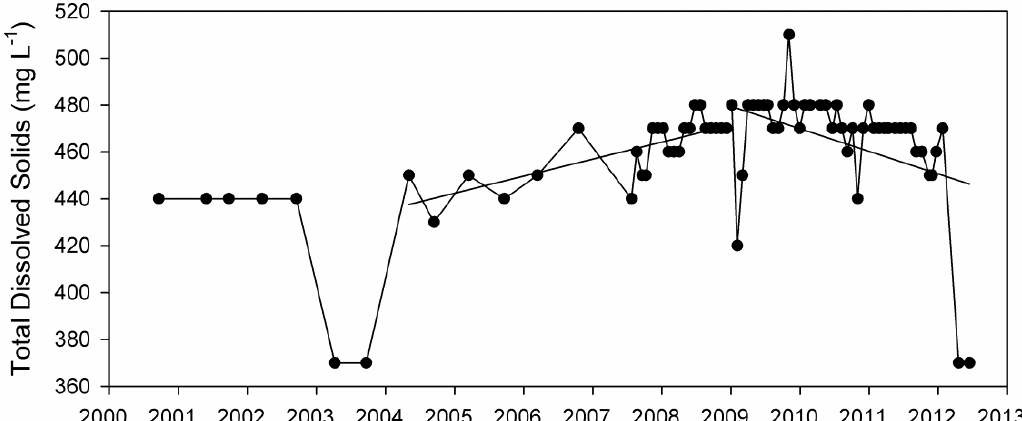
Figure 12. Coffin Bay TWS 3